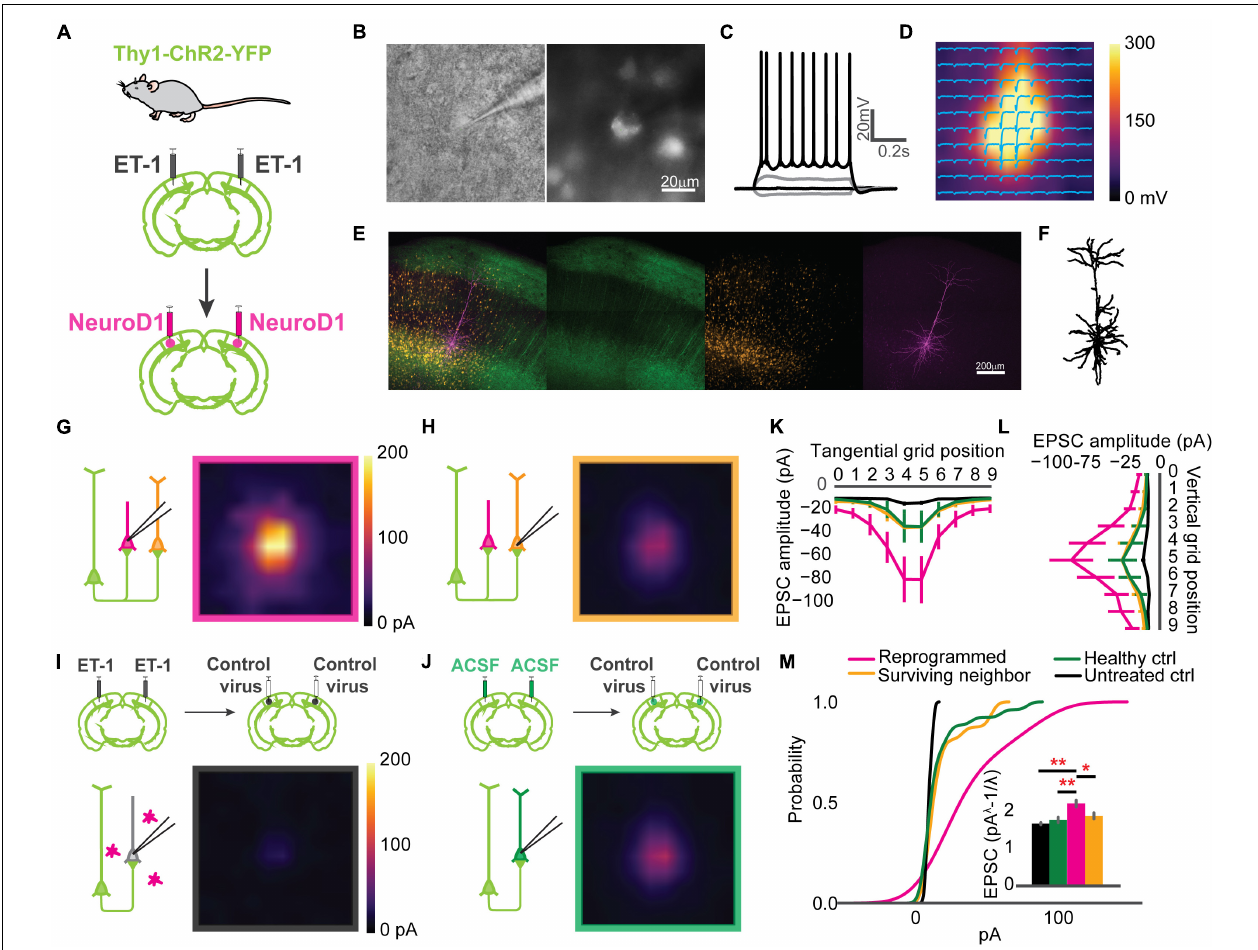
FIGURE 4 | Reprogrammed neurons are integrated into the local circuit and hyper-connected at an early stage. (A) Thy1-ChR2-YFP mice used for Channelrhodopsin-Assisted Circuit Mapping (CRACM) experiments. (B) An example whole-cell patch in Differential Interface Contrast (DIC) image (left) and epifluorescence image (right), showing a mCherry positive cell. (C) The cell in panel (B) showing evoked action potentials after step-current injection. (D) EPSC amplitudes of the cell in panel (B) shown in a CRACM heatmap overlaid with EPSC traces at each stimulation point. (E) Confocal images of showing a layer 5 neurons expressing ChR2-YFP (green) and reprogrammed cells expressing mCherry (orange). The patched cell filled with dye (magenta). Scale: 200 µ m. (F) Morphology of the cell processes from images in panel (E) . (G) Averaged CRACM heat map of mCherry positive reprogrammed cells ( N = 21 cells from 6 mice). (H) Same as (G) but for mCherry negative survived neighbors ( N = 16 cells from 6 mice). (I) Averaged CRACM heat maps of untreated ischemia control ( I , N = 19 cells from 4 mice). (J) Same as (I) but for healthy control ( N = 26 cells from 5 mice). (K) Averaged maximal EPSC ± SEM by grid position in the tangential direction (parallel to the brain surface). (L) Averaged maximal EPSC ± SEM by grid position in the vertical direction (perpendicular to the brain surface). (M) Cumulative density of EPSCs from each group. The inset bar graph showing Box-Cox-transformed EPSCs amplitude comparison among groups. Reprogrammed vs. Untreated: p = 0.001; Reprogrammed vs. Healthy: p = 0.001; Reprogrammed vs. Surviving: p = 0.0178, One-way ANOVA followed by Tukey post hoc tests. * p < 0.01 and ** p < 0.05, from Tukey’s HSD. Data are represented as mean ± SEM.